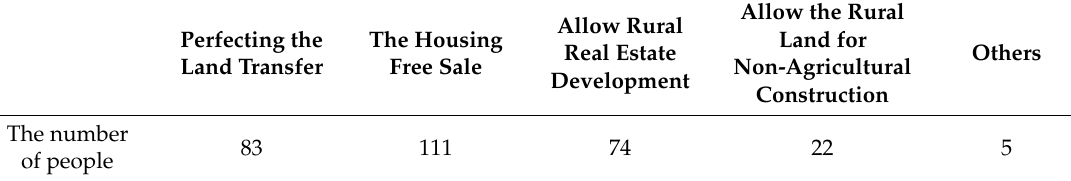
Table A3. Aspects that need improvement.